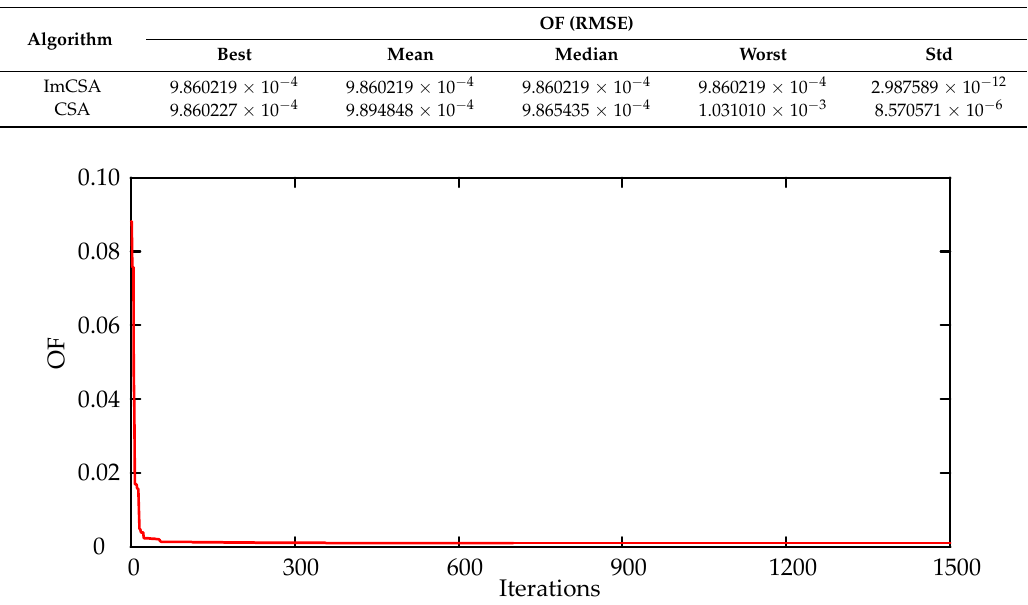
Table 1. Statistics of the OF (RMSE) values for the SDM of RTC France silicon solar cell using the proposed ImCSA and CSA.